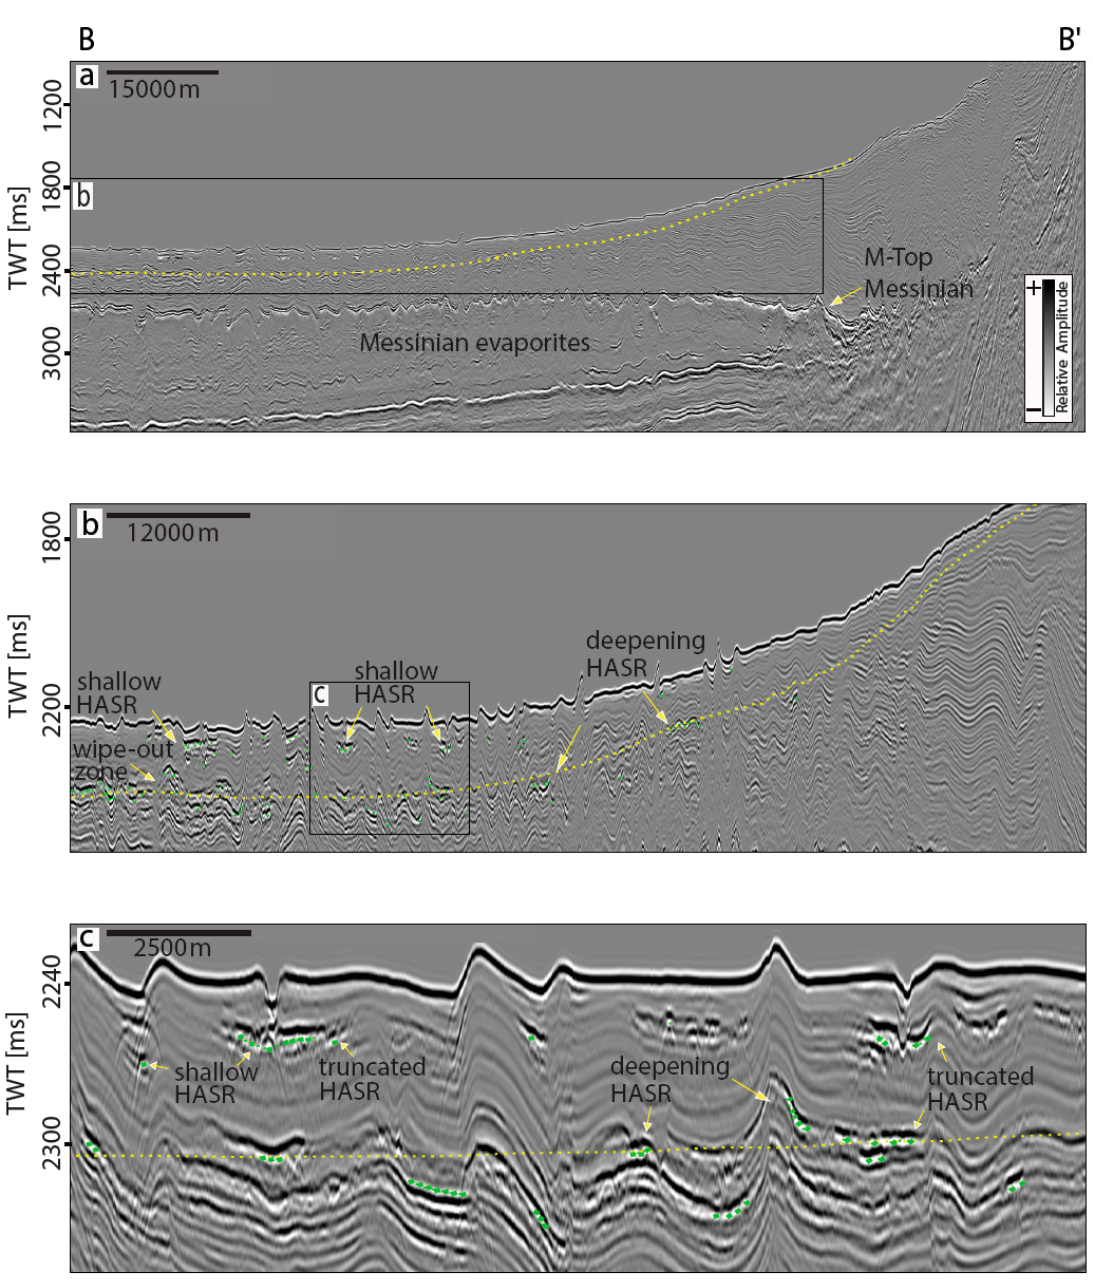
Figure 7. Seismic time migrated section B-B’ (Figure 1) of the TGS IS-2069 2D profile. The yellow dashed line represents the base GHSZ modeled with a thermal gradient of 28.5 ◦ C / km, while green dots represent the automatic HASR picks. ( a ) The full extent of the section down through the Messinian evaporites. ( b ) A zoom between 1780 to 2500 ms TWT in ( a ) showing the Shallow and Deepening HASR within the post-Messinian section. ( c ) A zoom on the rectangle in ( b ) depicting the truncated appearance and changing polarity of both the Shallow and Deepening HASR.